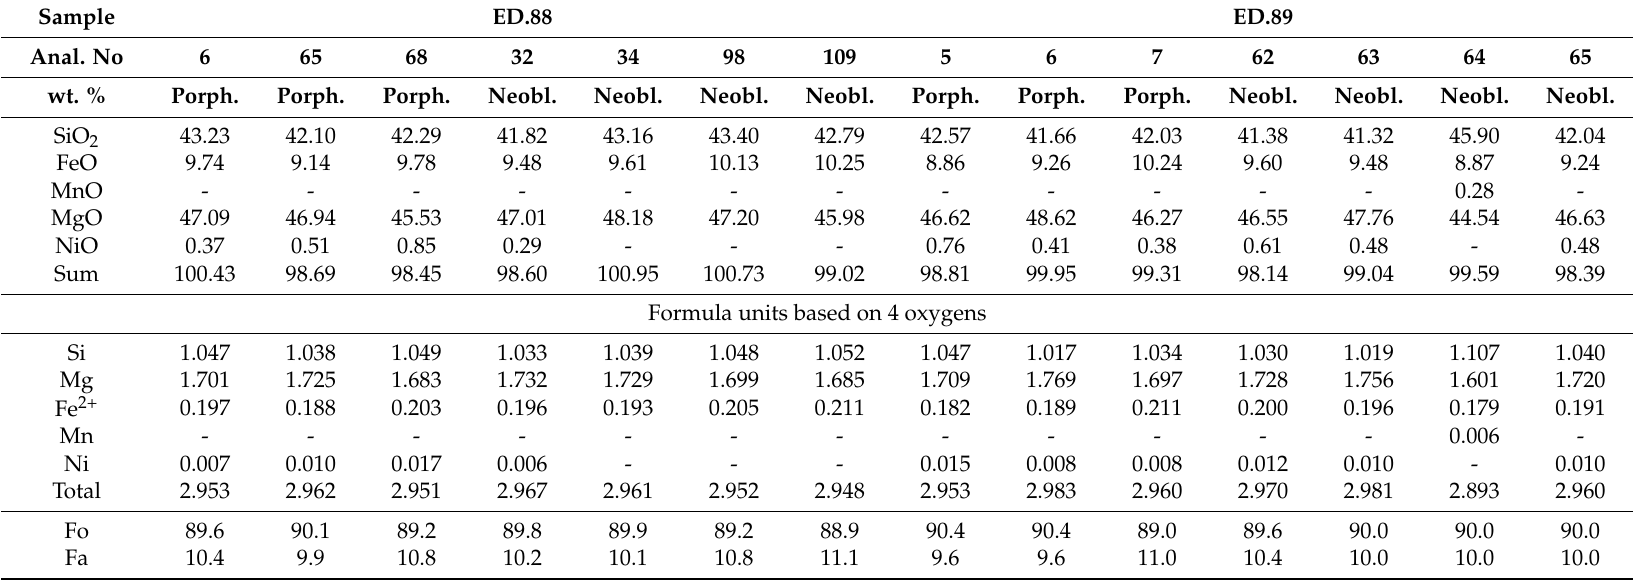
Table 4. Representative electron microanalyses of olivines from lherzolite of the Edessa ophiolitic complex (-: below detection limit).